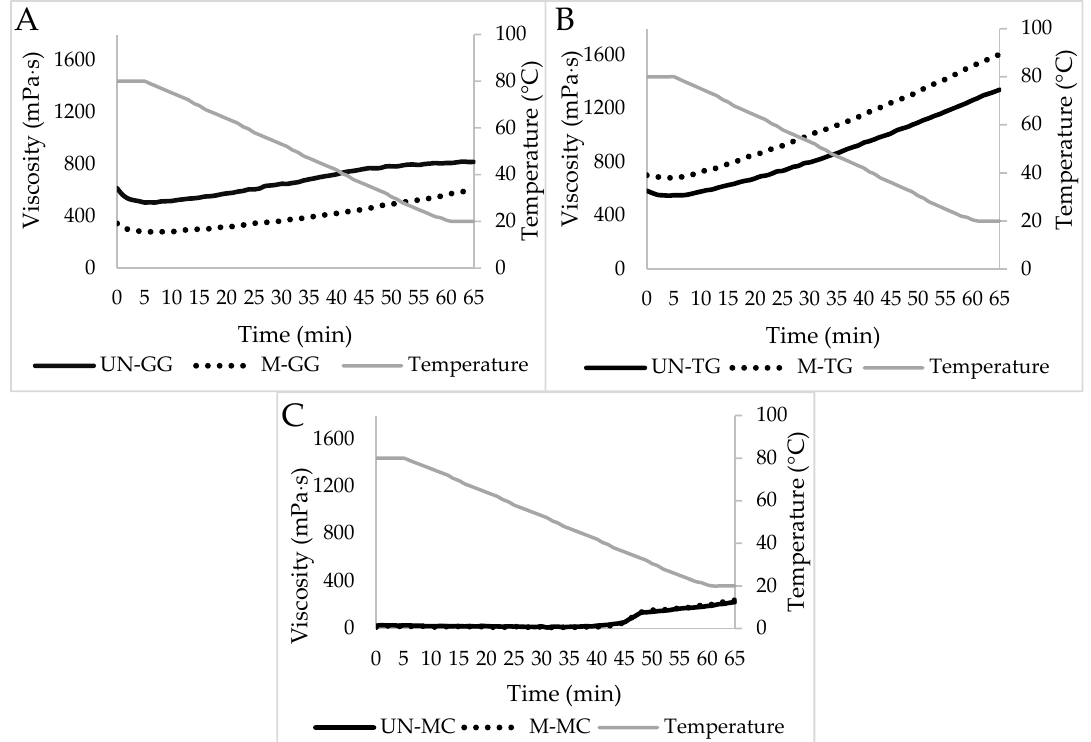
Figure 2. Gelling/thickening profiles of the three un-milled (continuous line) and milled (discontinuous line) hydrocolloids: guar gum ( A ), tara gum ( B ), and methylcellulose ( C ). UN: un-milled; M: milled; GG: guar gum; TG: tara gum; MC: methylcellulose.